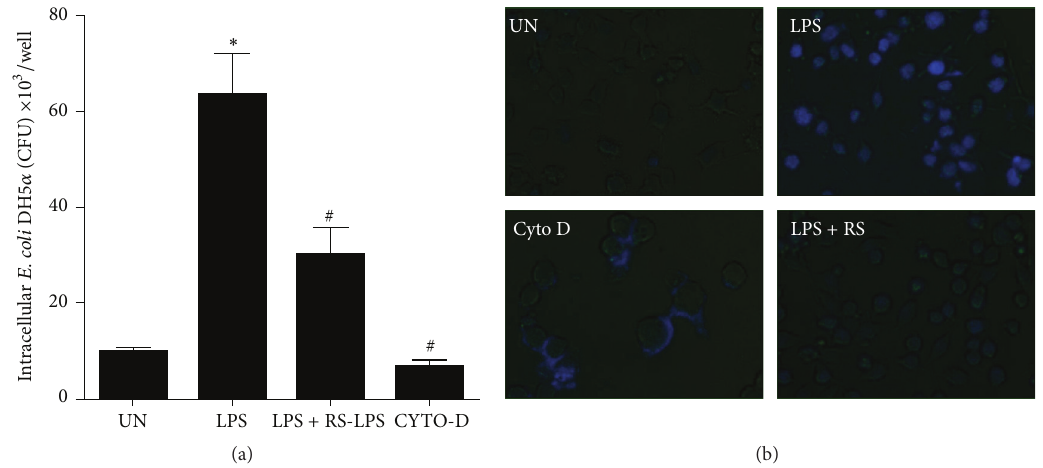
Figure 4: LPS-Rs diminished microglial phagocytic activity. Microglia phagocytic activity was measured by bacterial colony forming unit (CFU) count (a). BV2 microglia were pretreated with LPS-Rs (5 𝜇 g/mL) or Cytochalasin D (10 𝜇 M) for 2 hrs before LPS (1 𝜇 g/mL) treatment for 24 hrs. The cells were then infected with DAPI stained E. coli DH5 𝛼 . After 30 min gentamicin (200 𝜇 g/mL) was added for 1hr to kill extracellular bacteria and intracellular bacterial load was assayed using fluorescence microscopy at 40x magnification (b). The error bars represent the mean ± SEM from three independent experiments ( ∗ 𝑝 ≤ 0.05 versus control and # 𝑝 ≤ 0.05 versus LPS). UN: untreated; LPS: lipopolysaccharide from Escherichia coli 055 : B5 (1 𝜇 g/mL); RS: lipopolysaccharide from Rhodobacter sphaeroides (0.5–5 𝜇 g/mL); Cyto D: Cytochalasin